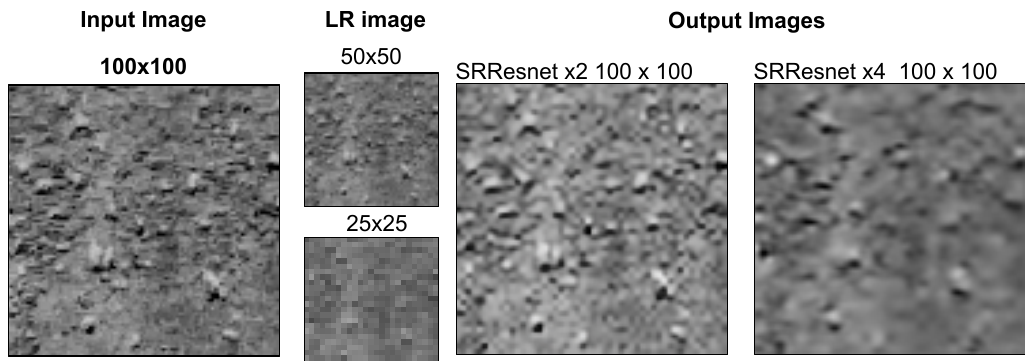
Figure 4. Example of a sub-image located at 54.9896°N, 13.1335°E at the different pixel dimensions. For better visualization, all images are magnified from the original size by a factor of 5. The 25 × 25 pixel LR image was magnified by a factor of 10 instead. The boulders are recognized by typical backscatter patterns, with high backscatter intensities facing the side scan sonar towfish, and acoustic shadows on the opposite side. It is observed that the image upscaled by a factor of 2 shows a slight increase in average greylevel